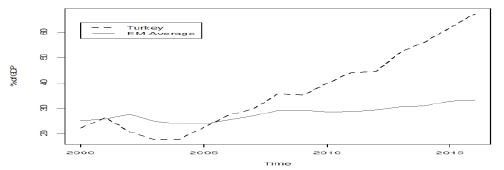
Figure 1. Real Sector’s Debt as a Percent of GDP in Comparison with other EMs Data Source: IMF International Statistics,